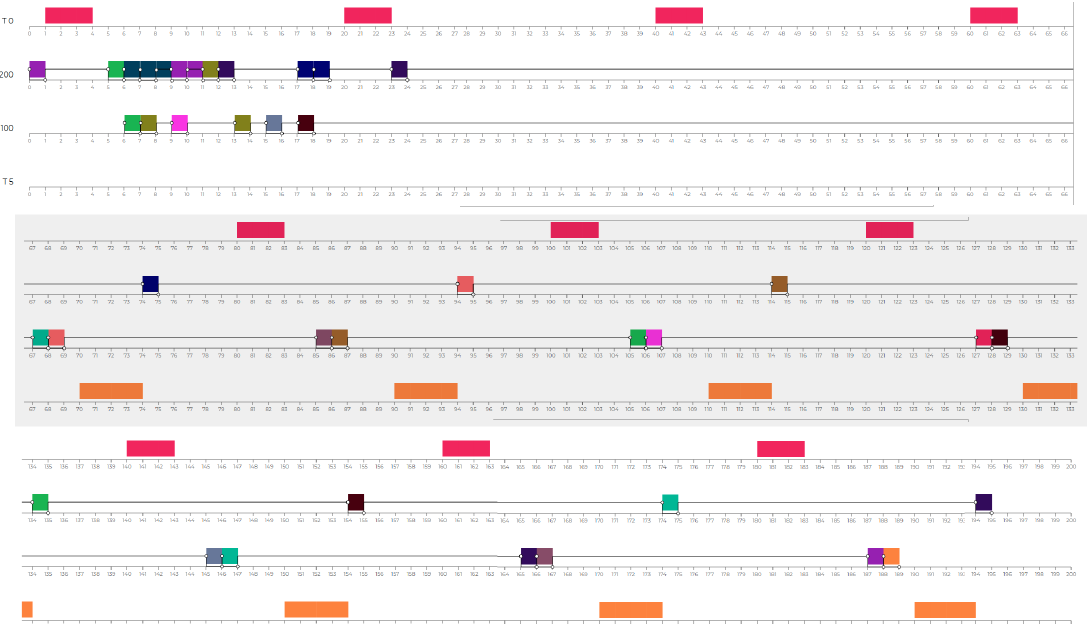
Figure 12. Graphical representation of the local scheduler of agent 2 in scenario S1, [0–200 s]. Due to the length of the selected period, the timeline is depicted in three lines. The task τ 5 (in orange) timely displays information after the inertial positions were reported from the agent